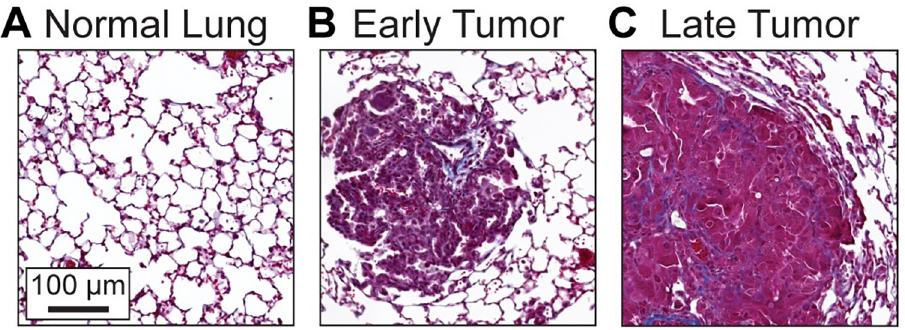
Fig 1. Early lung adenocarcinoma (LUAD) is characterized by alveolar filling. Lung tissue slides stained with Masson’s Trichrome to distinguish cells from connective tissue. Cell nuclei are dark purple, cytoplasm light red, and collagen blue. A. Alveolar architecture of normal lung from Kras +/+ ; Trp5 f/f mice. B. Tumor from Kras LSL-G12D/+ ; Trp53 f/f mice 10 weeks and C. 25 weeks after intra-tracheal inoculation with SPC-Cre. Images are representative of lung tissue from 3 Kras +/+ mice or tumors from 3 mice Kras LSL-G12D/+ mice at each time point.